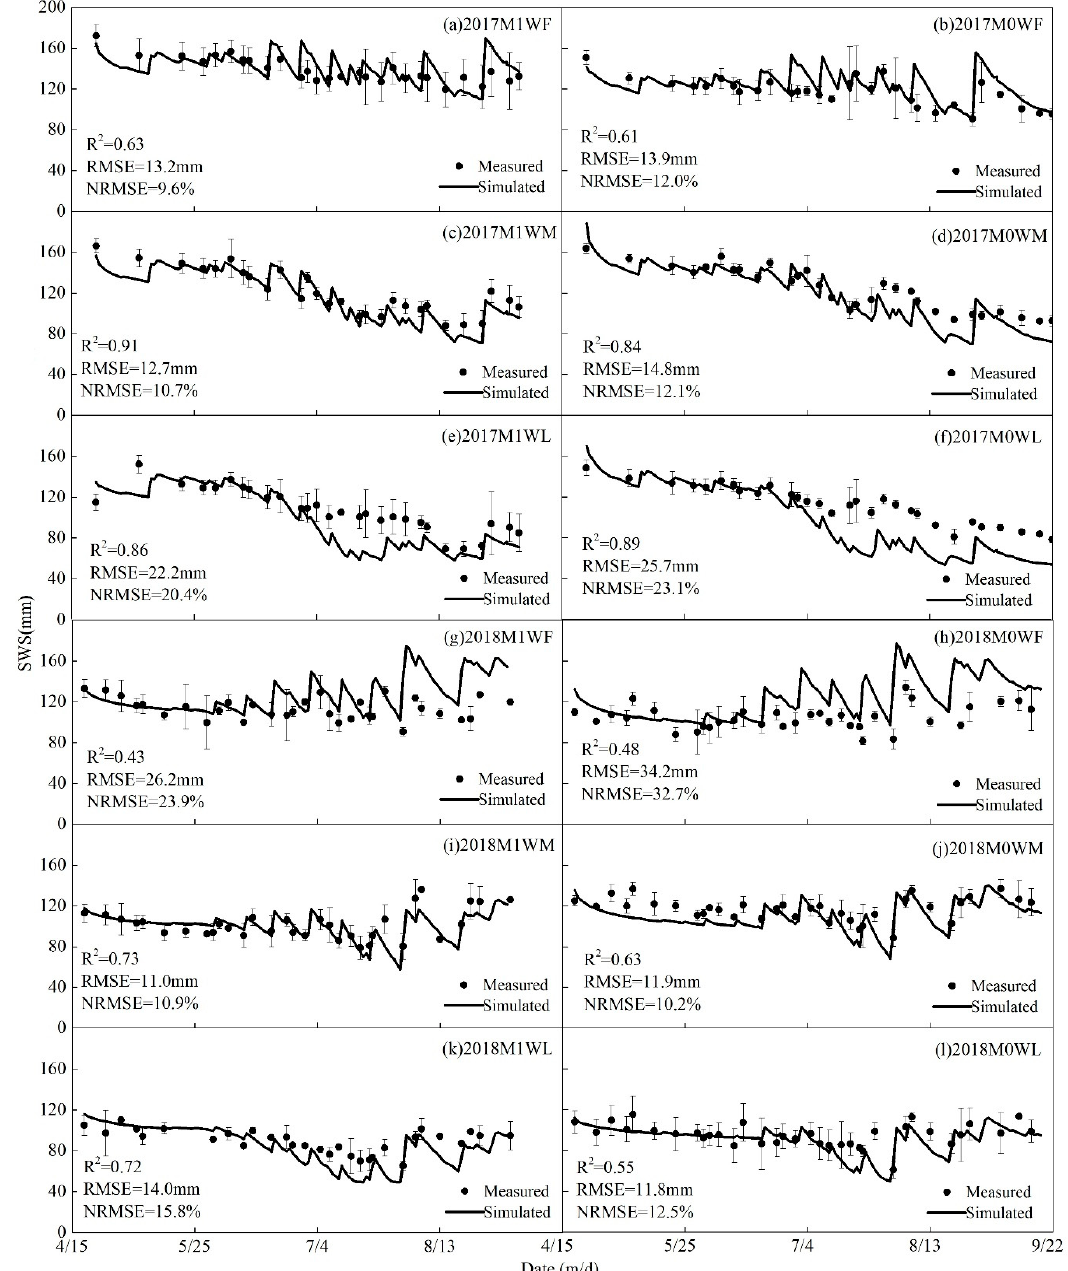
Figure 2. Comparison of the simulated and measured soil water storage (SWS) of 0–60 cm soil depths under di ff erent treatments during the growth period in 2017 ( a – f ) and 2018 ( g – l ). ( 1 R 2 , coe ffi cient of determination; RMSE, root mean square error; NRMSE, normalized root mean square error. 2 M1, mulching; M0, non-mulching; WF, full water irrigation (100%); WM, medium water irrigation (70%); WL, low water irrigation (40%). 3 Error bars were obtained by STDEV.S function of EXCEL with three random